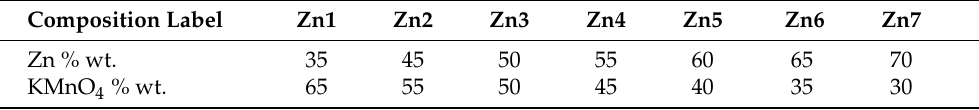
Table 1. Composition and sample naming scheme of investigated Zn/KMnO 4 PDC